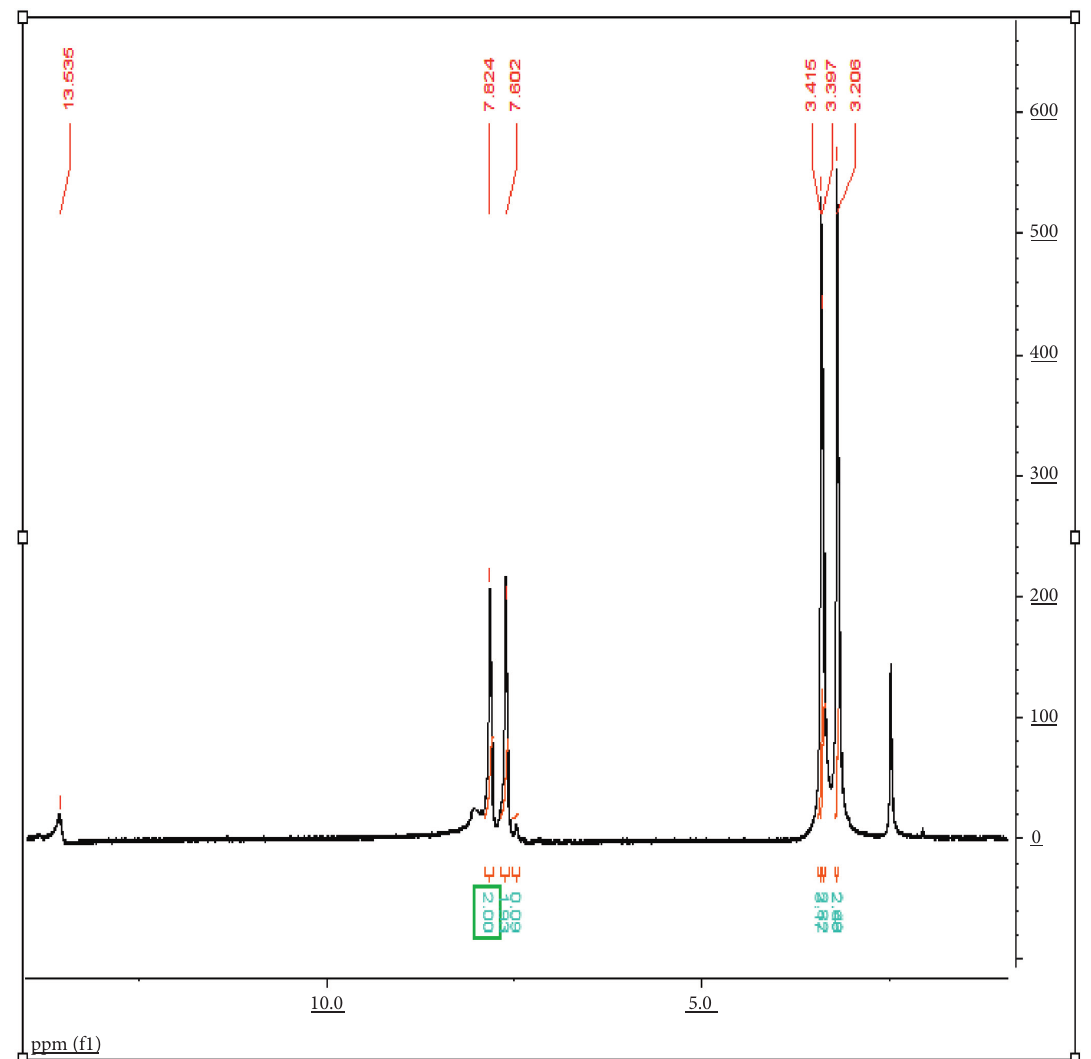
Figure 2: 1 H-NMR spectrum of CPAT dye in DMSO-d6 at 298K.